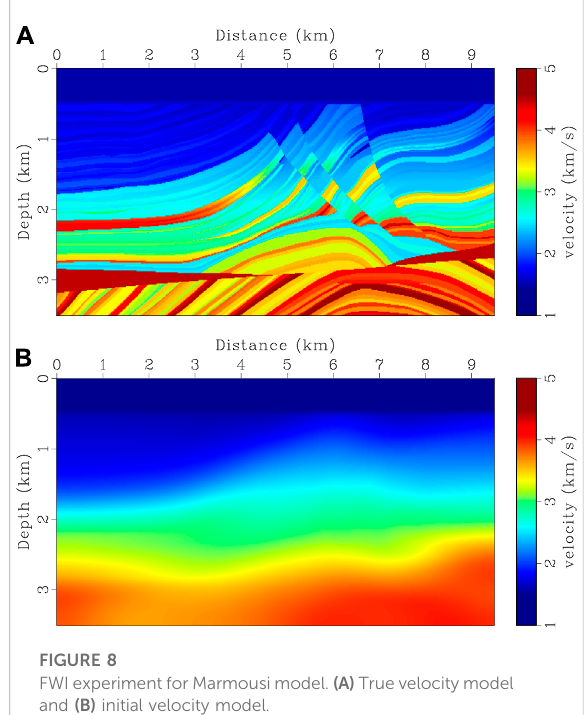
FIGURE 8 FWI experiment for Marmousi model. (A) True velocity model and (B) initial velocity